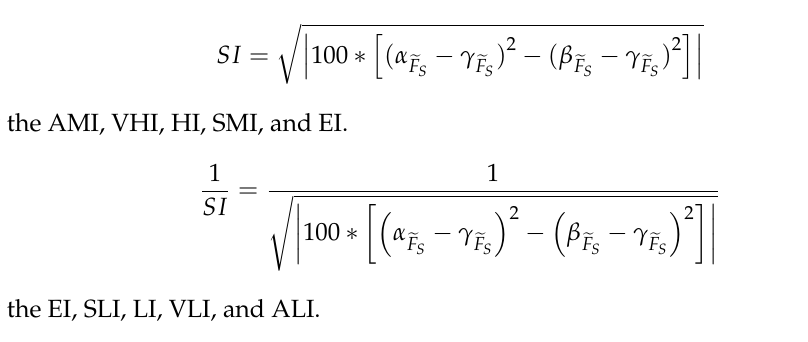
Table 2. AHP-SF linguistic scales and spherical fuzzy number ( α , β , γ )